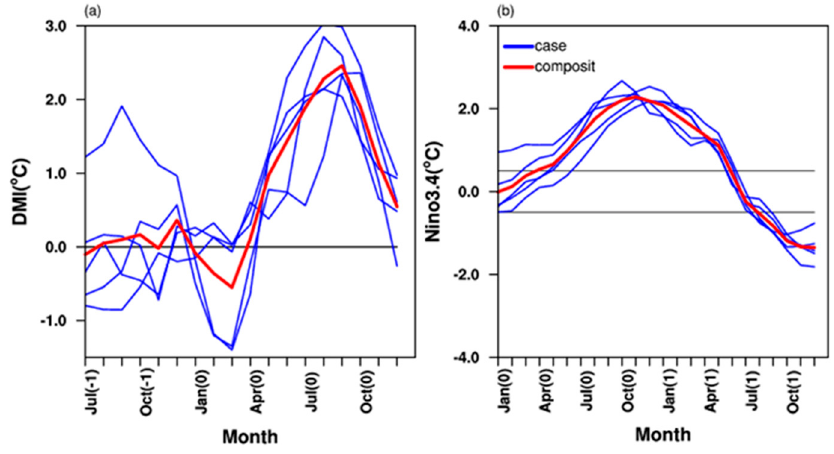
Figure 1. Time series of ( a ) DMI for the five pIOD events that occurred with El Niño from July ( − 1) to December (0) and that of ( b ) Nino3.4 for the El Niño events from January (0) to December (1) in the GFDL CM2p1. The blue and red curves represent the individual event and their composite mean, respectively.